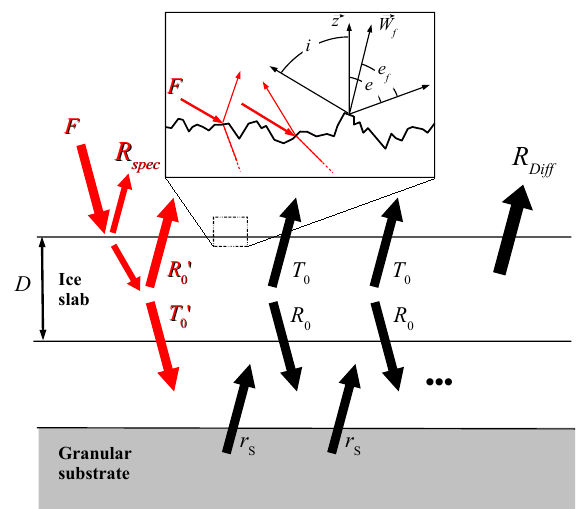
Figure 2. Illustration of the radiative transfer in the surface medium. Anisotropic transits are represented in red. F is the incident radia- tion flux, R spec and R Diff are the specular and diffuse contributions to the reflectance of the surface respectively, r s is the Lambertian re- flectance of the granular substrate and R 0 and T 0 are the total reflec- tion and transmission factors of the slab layer respectively. A prime indicates an anisotropic transit. The reflection and transmission fac- tors are different in the cases of isotropic or anisotropic conditions. The granular and slab layers are artificially separated in this figure to help the understanding of the coupling between the two layers. Top: illustration of the reflections and transmission at the first in- terface, used in the calculations of R spec and the determination of the amount of energy injected into the surface. z is the normal to the surface, W f the local normal to a facet, i and e are the incidence and emergence angles respectively and e f is the local emergence angle for a facet. Each different orientation of a facet will lead to a dif- ferent transit length in the slab. A more detailed description can be found in Andrieu et al.